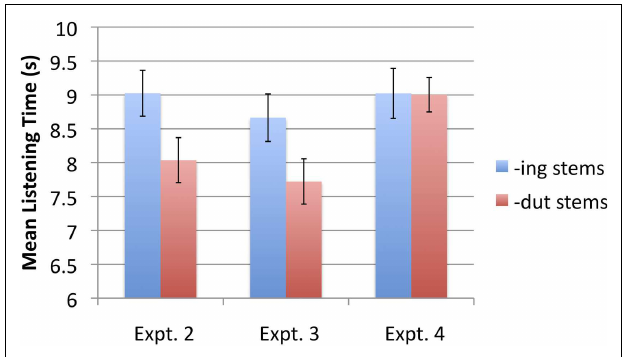
FIGURE 4 | Mean listening times to -ing stem and -dut stems in Experiments 2–4.